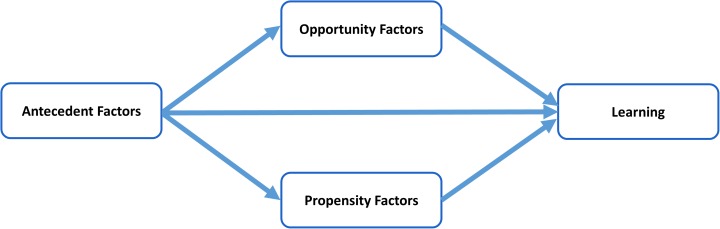
The Opportunity-Propensity Model. Adapted from Byrnes and Miller (2007, p. 602).